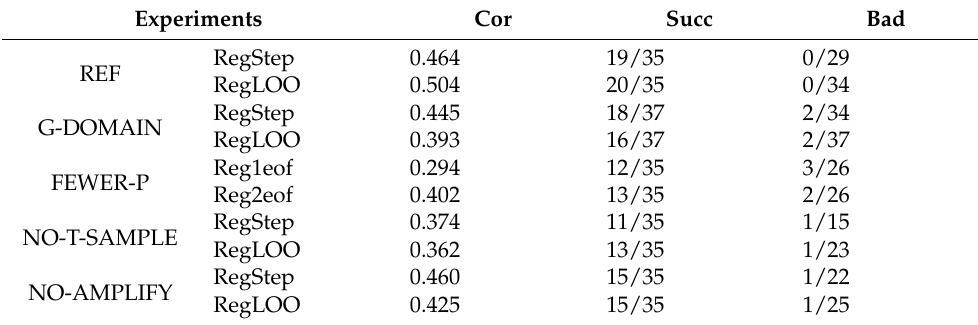
Table 3. List of the forecast skills (Cor, Succ, and Bad) from all experiments.